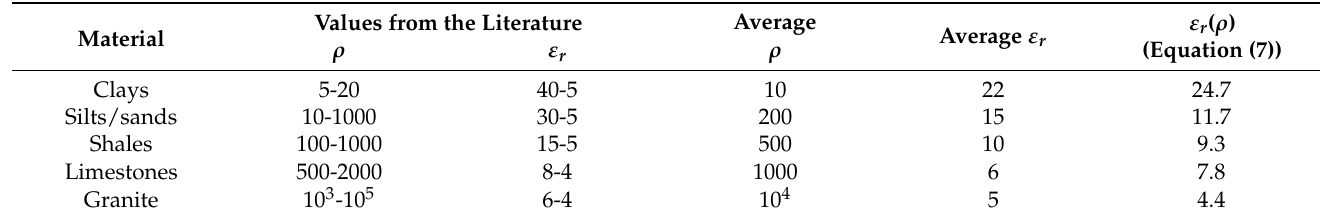
Table 2. Comparison of resistivity and relative permittivity values obtained from the literature [35,42,64] and those calculated from Equation